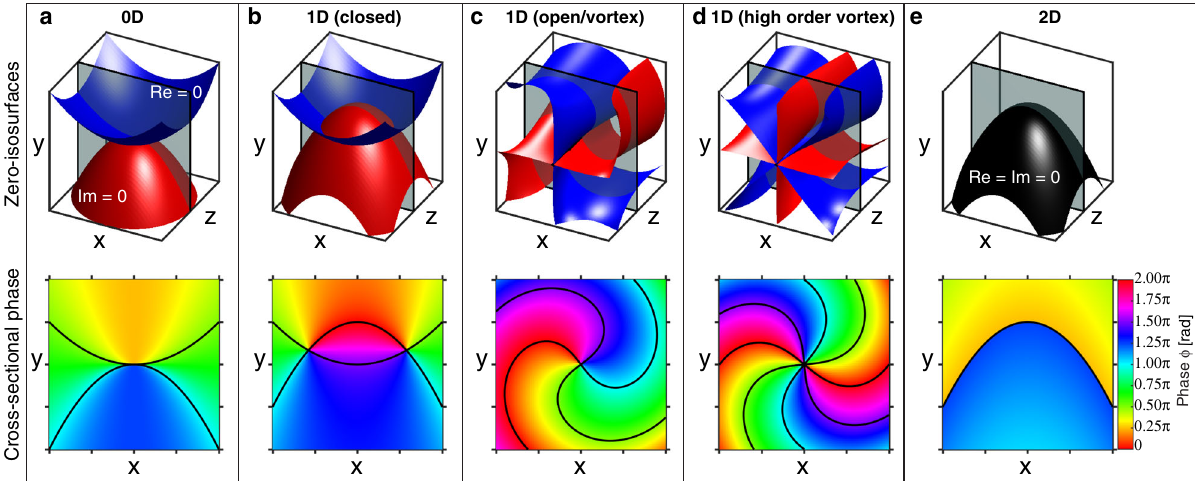
Fig. 1 Intersection topologies of zero-isosurfaces that form optical singularities. Optical singularities are formed at the intersection of the zero- isosurfaces of the real (Re) and imaginary (Im) parts of a complex fi eld (e.g., a linearly polarized electric fi eld). Top row: intersection topologies of the two zero-isosurfaces (blue: Re = 0, red: Im = 0). Bottom row: phase pro fi les for each intersection topology in the top row, evaluated at the gray cross-sectional plane. Black lines indicate the zero-valued contours on the cross-sectional plane. a When the zero-isosurfaces intersect at a point, a 0D point singularity is formed. 1D singularities can be formed as b a closed loop or c , d an open line. c The fundamental Laguerre – Gaussian 0,1 vortex beam, with its corkscrew-like zero-isosurfaces. d A higher-order Laguerre – Gaussian 0,2 vortex beam has more than one pair of zero-sheets intersecting along a line. e When the zero- isosurfaces coincide, the singularity is